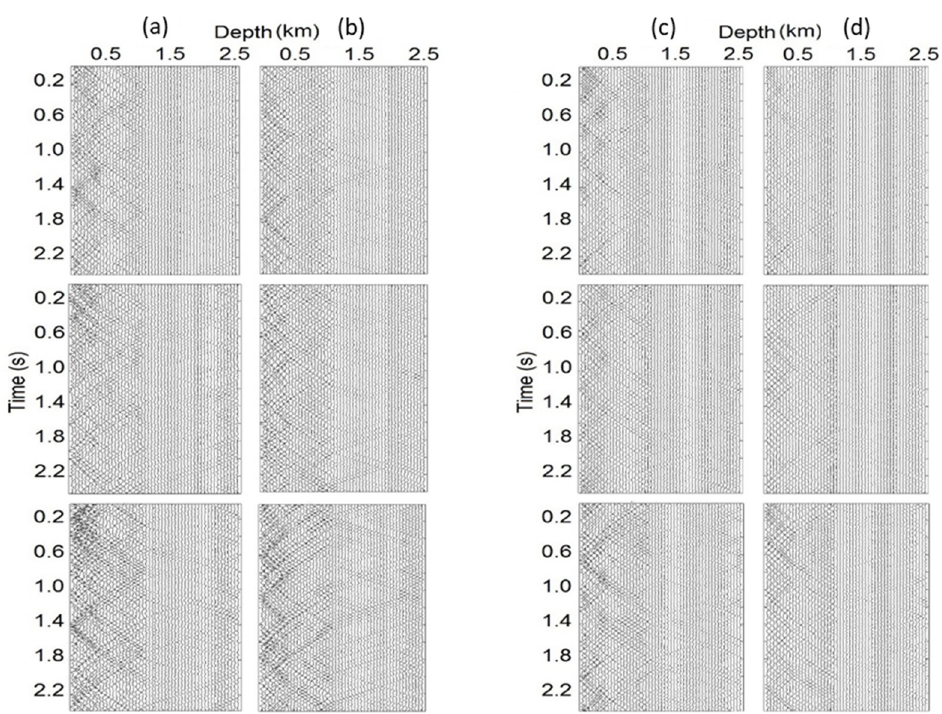
Figure 14. Virtual shot gathers created from the crosswell survey for noise generated within bound- aries 1, 2, 3 and 4, in columns ( a – d ), respectively. The top images represent base surveys, the middle images repeat surveys, and the bottom images the difference between base and repeat surveys.